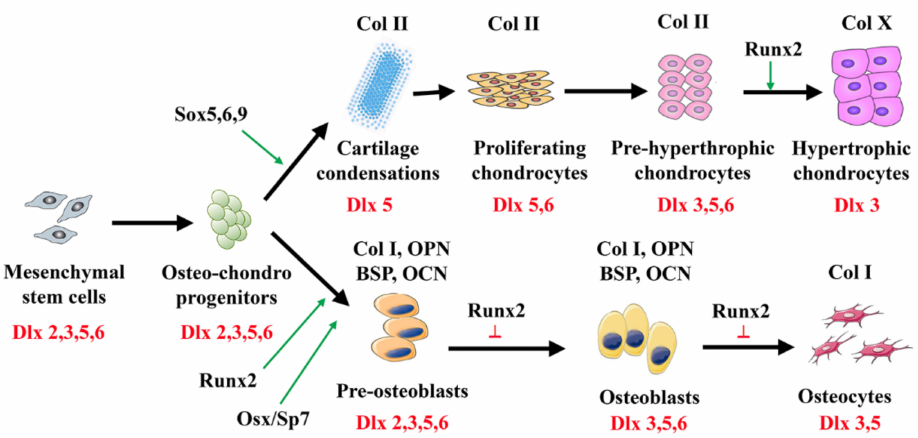
Figure 1. Role of Dlx transcription factors in the control of cartilage and bone differentiation. Os- teoblasts and chondrocytes differentiate from common mesenchymal skeletal stem cells. Dlx genes are essential for the commitment of progenitors to both the chondrocytic and osteoblastic lineage and for the differentiation of both osteoblasts and chondroblasts. Abbreviations: Col-I/II/X, type I/II/X collagen; BSP, bone sialoprotein; OPN, osteopontin; OCN,